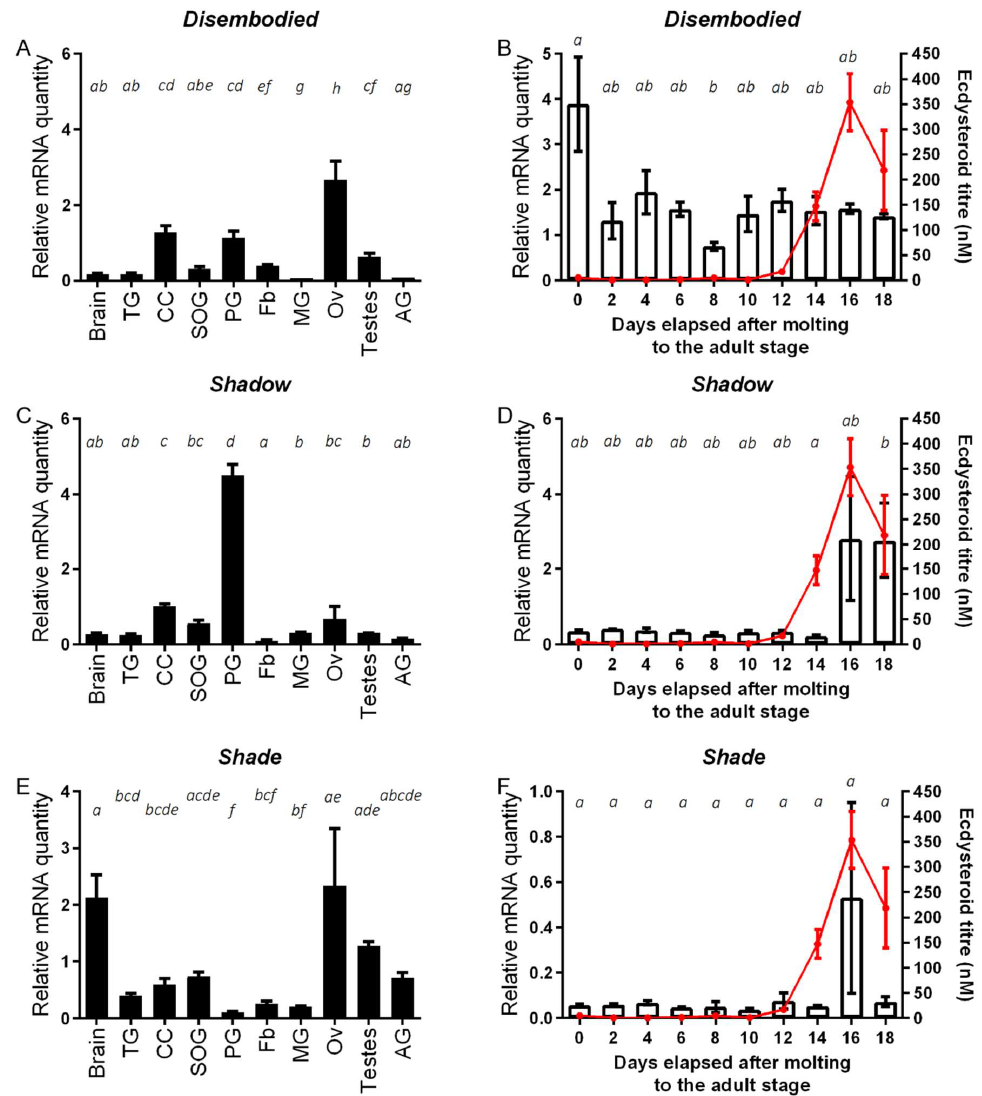
Figure 1. Tissue and temporal distribution of SchgrDib, SchgrSad and SchgrShd transcripts . Relative transcript levels of ( A ) SchgrDib , ( C ) SchgrSad and ( E ) SchgrShd measured in different tissues of adult locusts, using qRT-PCR. All tissues were dissected from adult female locusts 10 days after the final molt, except for the male accessory glands (AG) and testes. The data represent mean ± S.E.M. of three independent pools (10 animals/pool), run in duplicate and normalized to ribosomal protein 49 (RP49) and elongation factor 1 α ( EF1 α ) transcript levels. Other abbreviations on the X-axis: TG: thoracic ganglia; CC: corpora cardiaca ; SOG: suboesophageal ganglion; PG: prothoracic glands; Fb: fat body; MG: midgut; Ov: ovaries. Temporal distribution profile of ( B ) SchgrDib , ( D ) SchgrSad and ( F ) SchgrShd in the ovaries during the first reproductive cycle. Using qRT-PCR, relative transcript levels of SchgrDib , SchgrSad and SchgrShd were measured every other day in the ovaries, starting on the day of molting to the adult stage (AdD0). Data represent mean ± S.E.M. (bars) of three independent pools of ten animals each, run in duplicate and normalized to β -actin and EF1 α transcript levels. The ecdysteroid titer (red line), expressed in nM, throughout the first reproductive cycle was measured with an enzyme immunoassay (EIA). The data represent mean ± S.E.M. of 6–18 hemolymph samples taken from different animals per time point. Significant differences are indicated using letters as described by Piepho (2018), meaning that conditions having a letter in common do not significantly differ from each other (One-way ANOVA with Tukey’s multiple comparison test on log-transformed data)